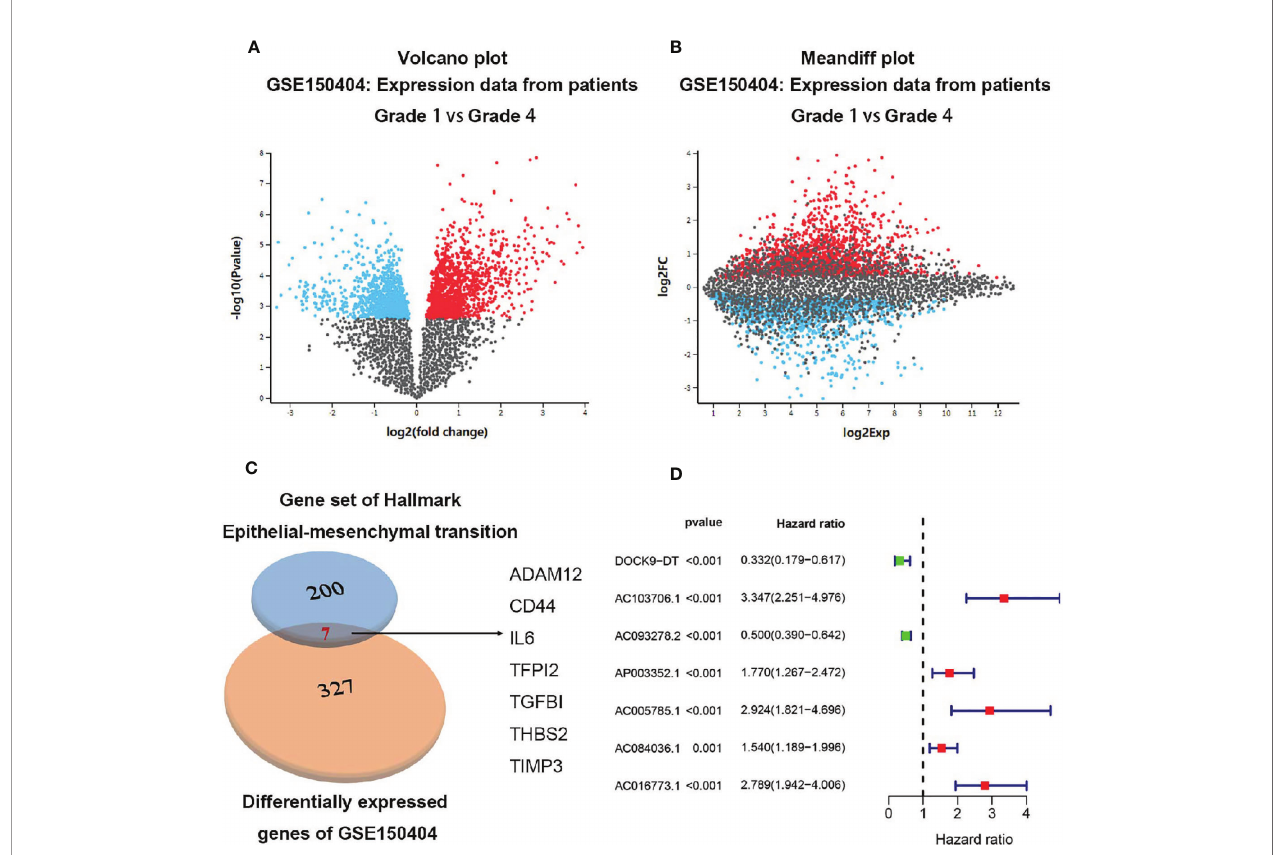
FIGURE 1 | Identi fi cation of the 7 metastasis-related genes. (A) Volcano plot of expression data from patients grade 1 vs grade 4 in GSE150404. (B) Meandiff plot of expression data from patients grade 1 vs grade 4 in GSE150404. (C) Biovenn was utilized to get the intersection of the 327 DEGs and the 200 EMT-related genes, and fi nally 7 metastasis-related genes consisting of ADAM12, CD44, IL6, TFPI2, TGF- b 1, THBS2, TIMP3 were identi fi ed. (D) 7 metastasis-related lncRNAs were supposed to be independent prognostic factors in ccRCC patients after multivariate Cox regression analysis.